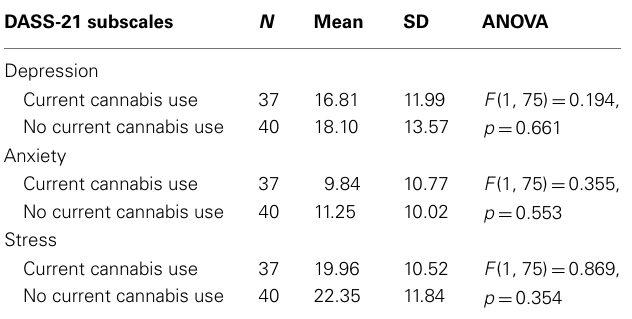
Table 4 | Current cannabis* users versus non-current users as a function of current depression, anxiety, and stress, as measured by the